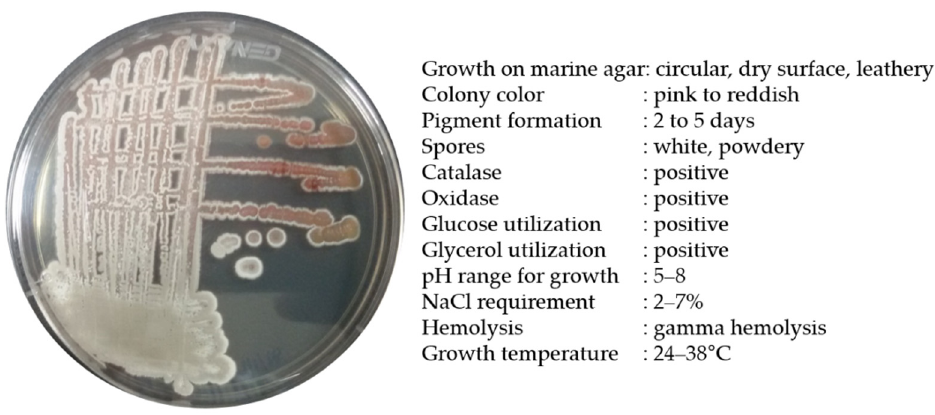
Figure 2. Morphological and biochemical characteristics of Streptomyces sp. strain BSE6.1.